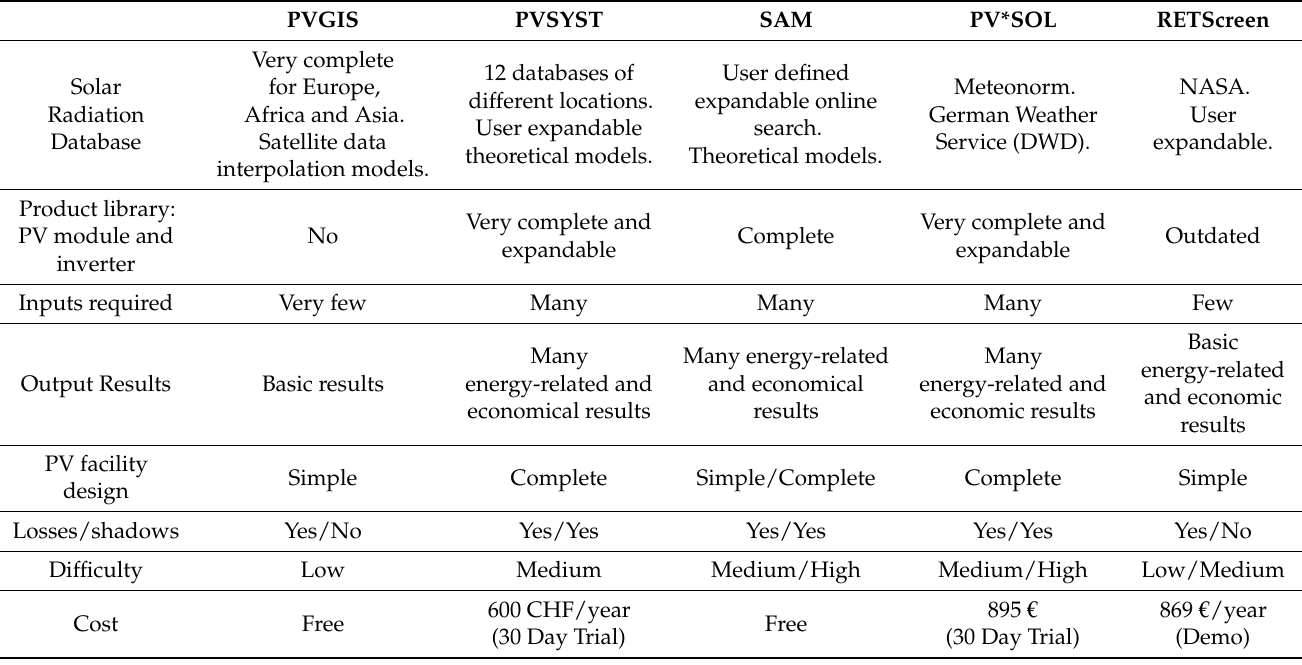
Table 1. Software tools technical